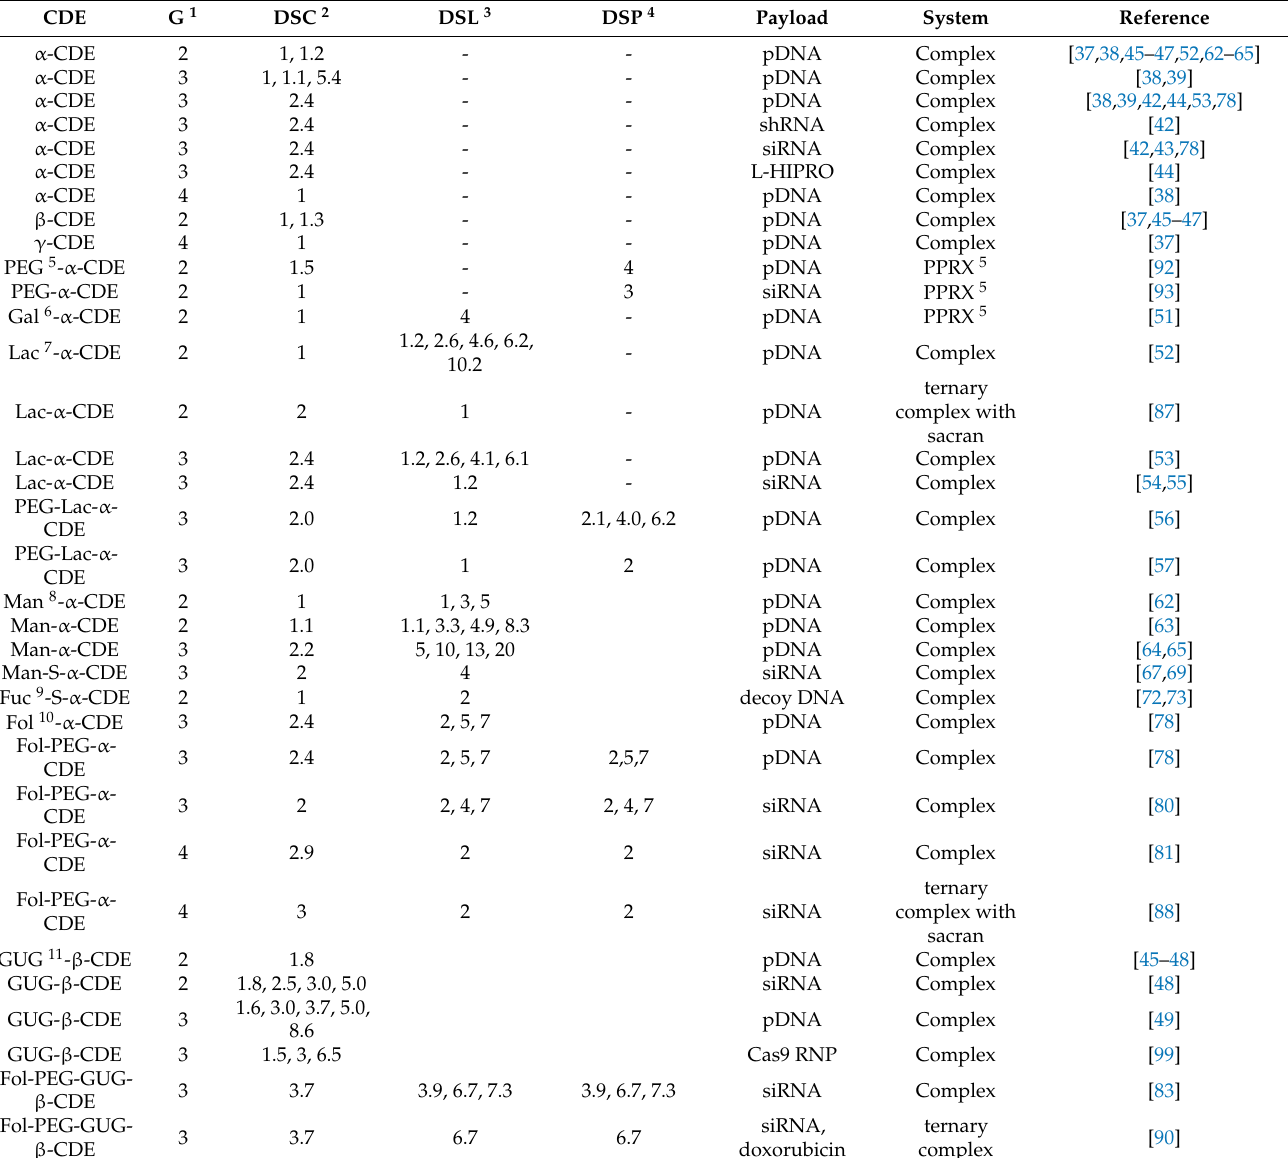
Table 4. Various multifunctional CDEs introduced in the